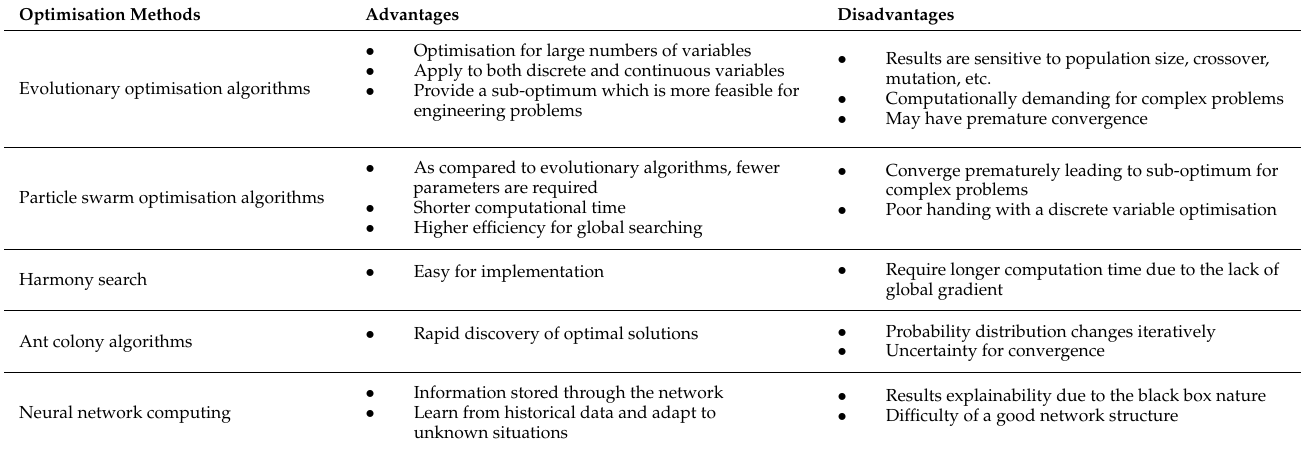
Table 4. Advantages and disadvantages of various algorithms for DfM